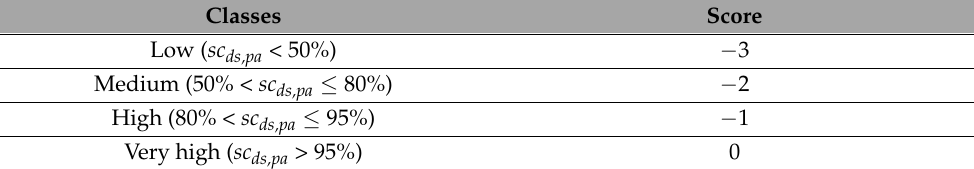
Table 6. SC ds,pa —spatial coverage.